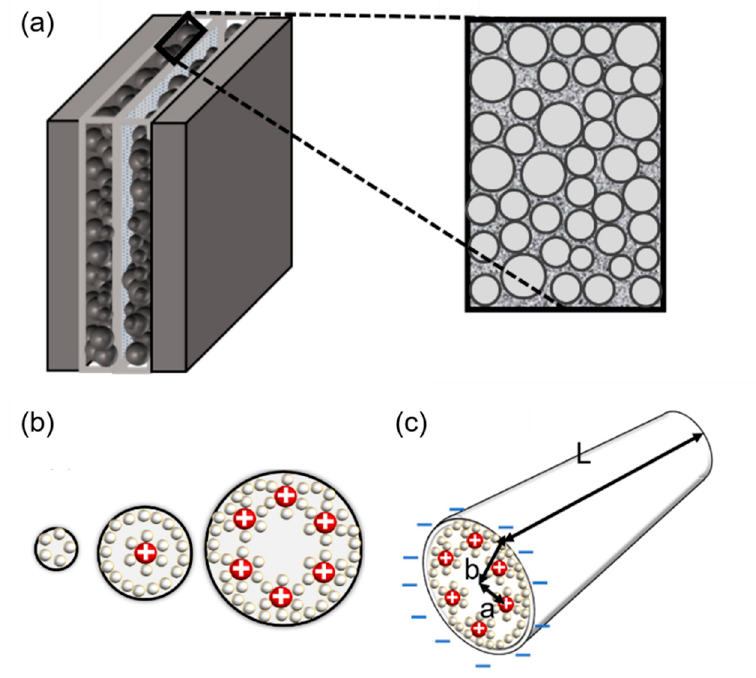
Figure 3. ( a ) Brief structure of a supercapacitor with a view of cylindrical theory (endohedral capacitors/electric double-cylinder capacitor), ( b ) shape of the electrolyte ion placed and